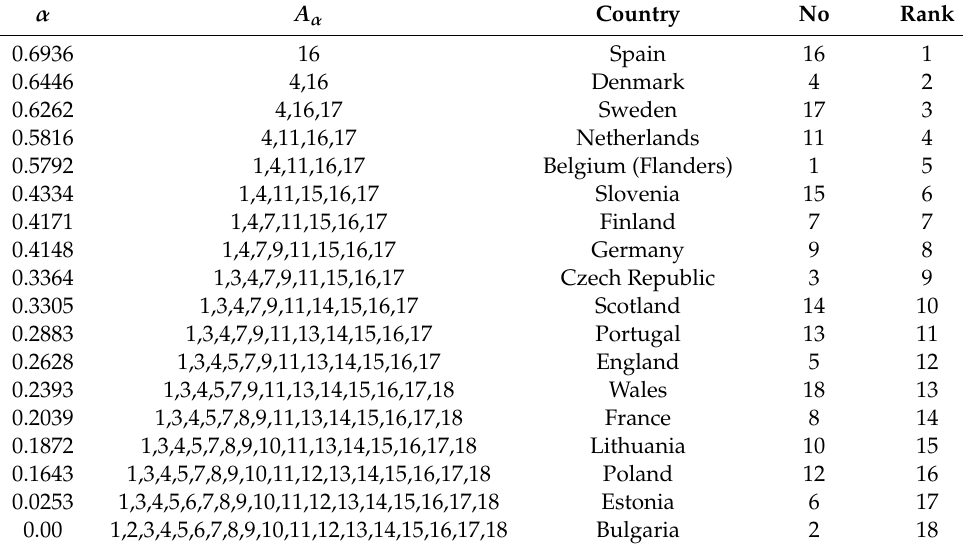
Table 5. α values, α -cuts and ranks of European countries for matrix R 1 .